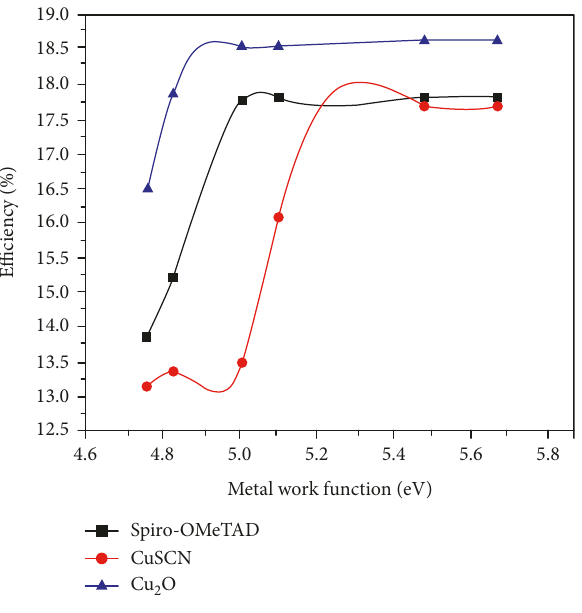
Figure 8: Metal work function versus e ffi